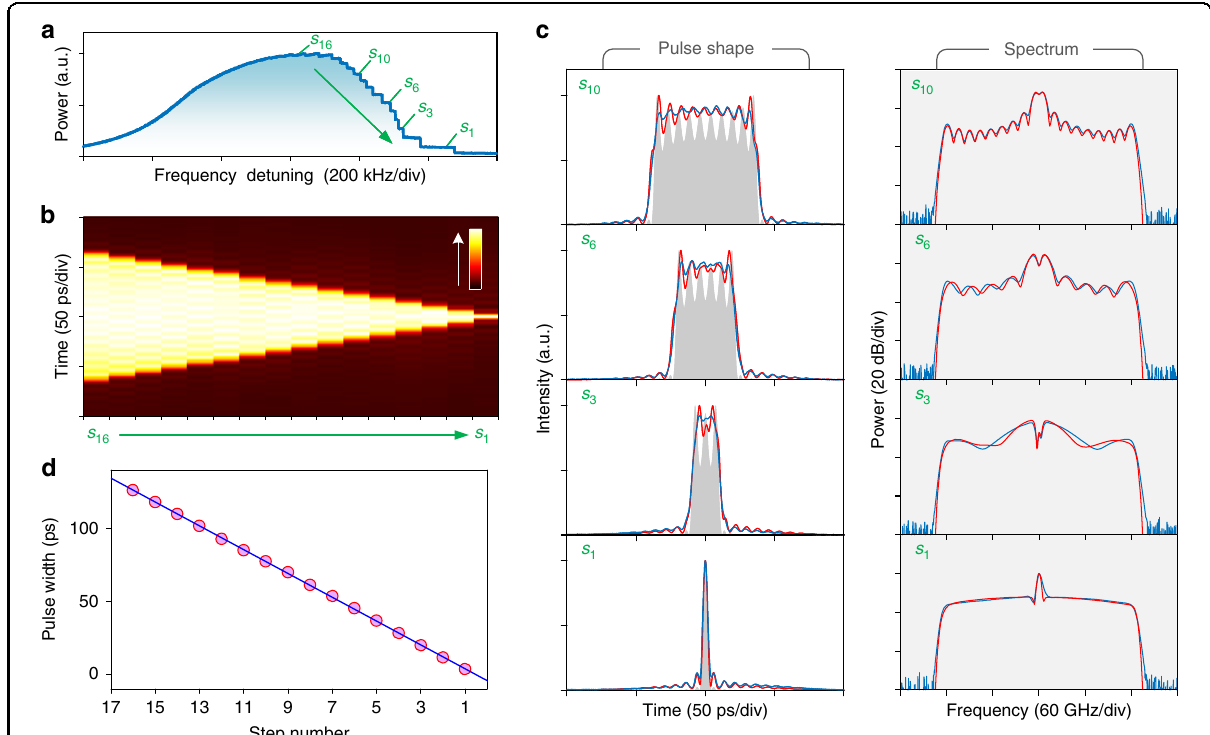
Fig. 3 Nyquist soliton transition dynamics under pulsed pumping. a Intracavity power versus pump frequency detuning. Steps corresponding to soliton state transitions are clearly observed. b Evolution of the soliton waveform with the transition step. The color gradient represents the optical intensity. c Pulse shape (left) and spectrum (right) at different steps marked in ( a ). Blue, measured; red, simulated. The gray shadows indicate the simulated soliton molecules sustained by a balance between Kerr nonlinearity and spectral fi ltering alone. With the increase of pump detuning, the soliton number decreases one by one, until a single Nyquist soliton is formed at the last step. d Total width of the soliton molecule at each step. Red circles, measured; blue line, linear fi